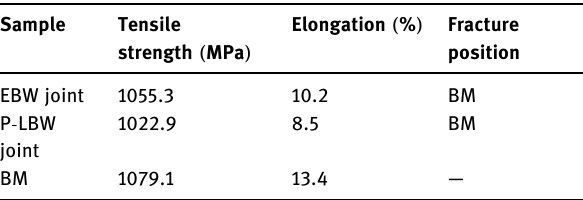
Table 3: Results of tensile tests of base metal and welded joints Sample